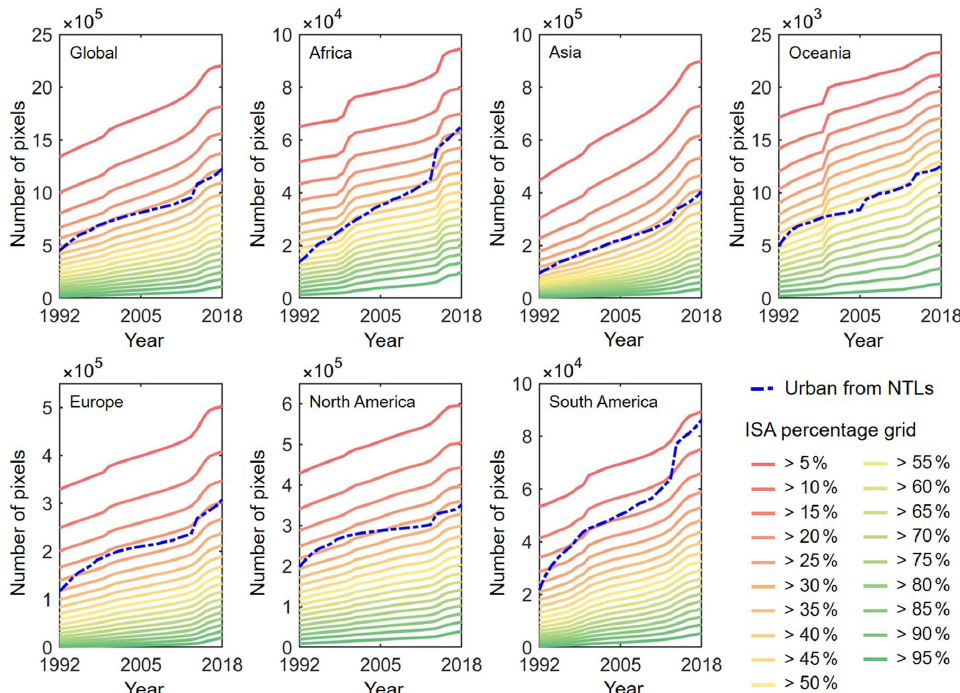
Figure 7. Comparisons of urban extent from NTL imagery with the ISA percentage map calculated from GAIA data from 1992 to 2018 at the global and continent